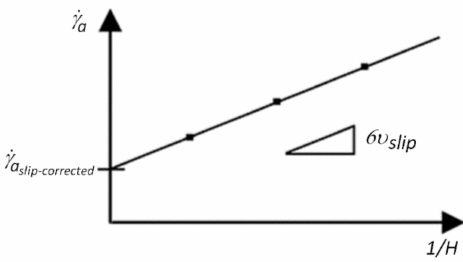
Figure 3. Calculation of wall-slip